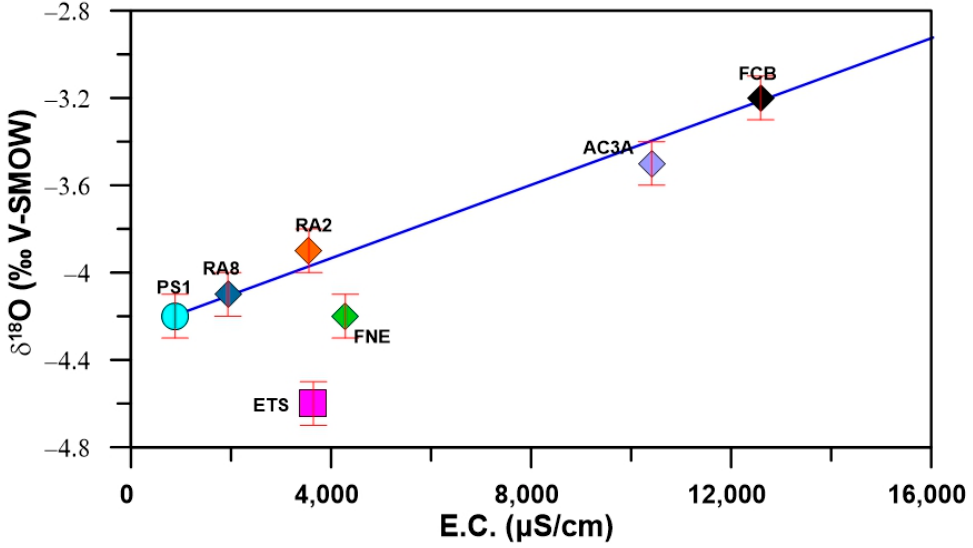
Figure 6. Electrical Conductivity (E.C.)- δ 18 O scatter diagram of sampled waters. Blue line: seawater—freshwater mixing line.